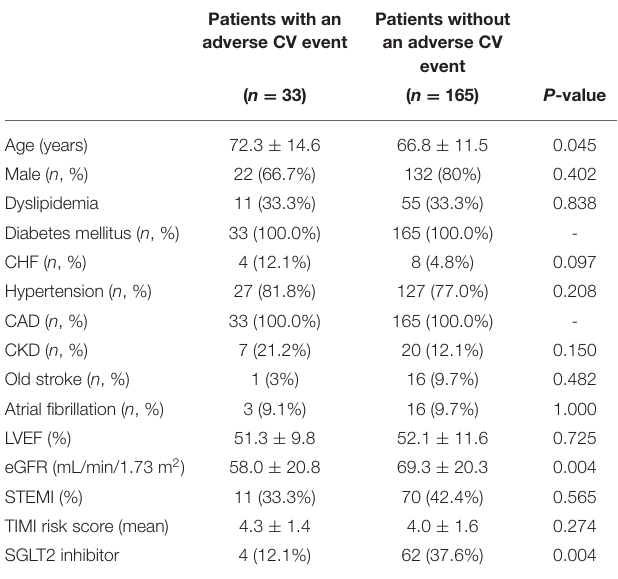
TABLE 2 | Comparison between patients with vs. without adverse cardiovascular events.